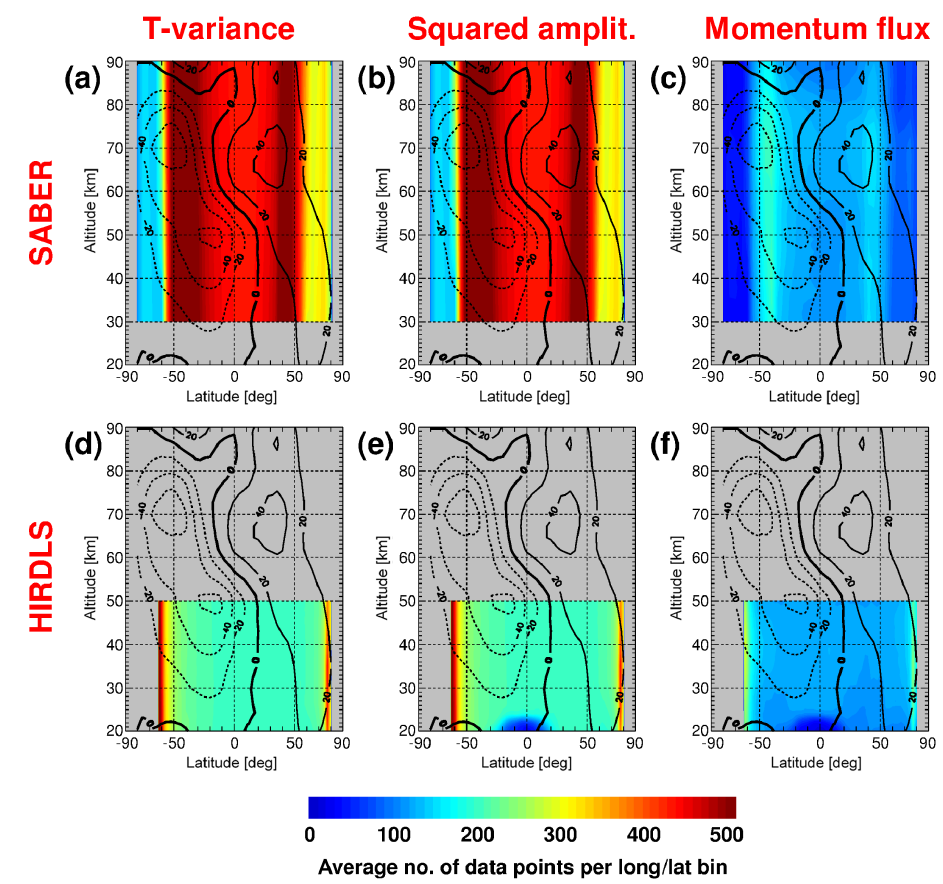
Figure 15. Latitude–altitude cross sections of the number of values per long/lat bin used for global maps, zonally averaged for the average month of January. Shown are multi-year averages for SABER (a,b,c) and HIRDLS (d,e,f) for average global maps of gravity wave temper- ature variances (a,d) , squared amplitudes (b,e) , and absolute momentum fluxes (c,f) . Overplotted winds are from the SPARC climatology (Swinbank and Ortland, 2003; Randel et al., 2002, 2004). Westward (eastward) winds are indicated by dashed (solid) contour lines. The zero wind line is bold solid. The contour line increment is 20ms − 1